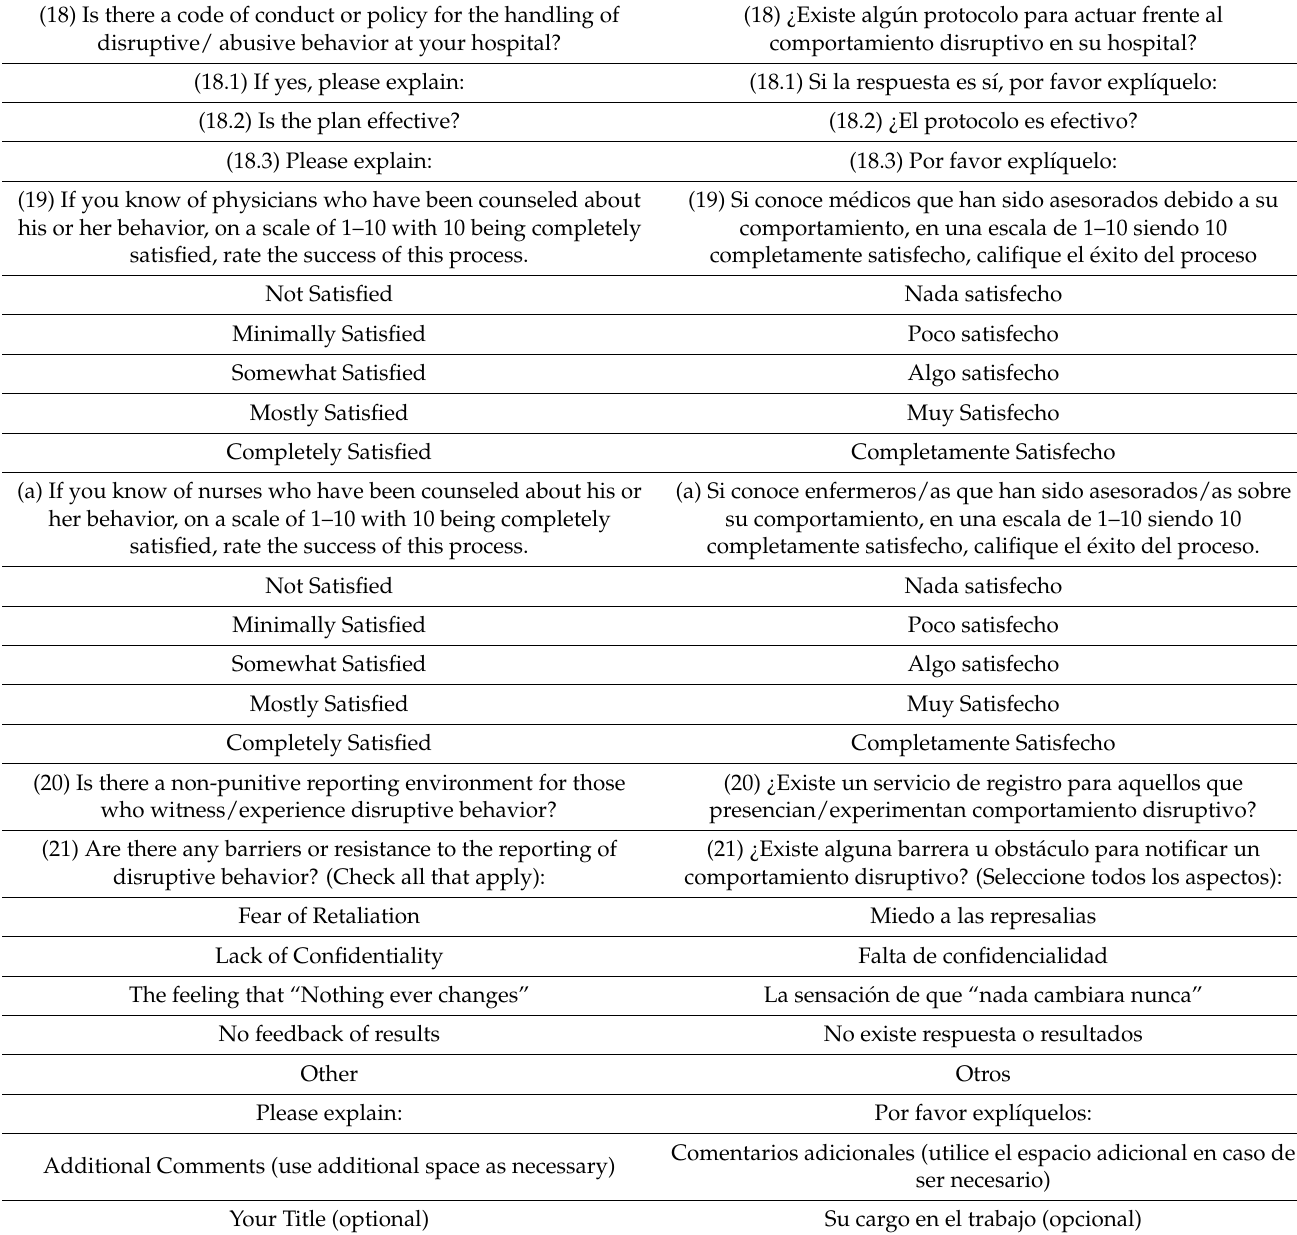
Table A1. Cont. Versi ó n